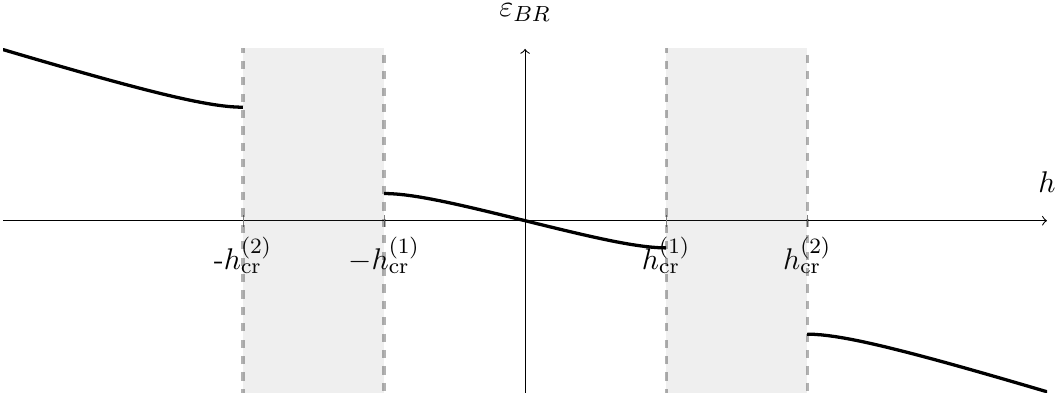
= (cid:34) ( α σ ) of the boundary root as a function of the BR BR = 2 and h ( 2 ) = 4. The dressed energy (cid:34) is an BR cr cr = π when h → − h ( 1 ) , h > − h ( 1 ) , and it h 2 cr cr = 0 when h → − h ( 2 ) , h < − h ( 2 ) h cr cr